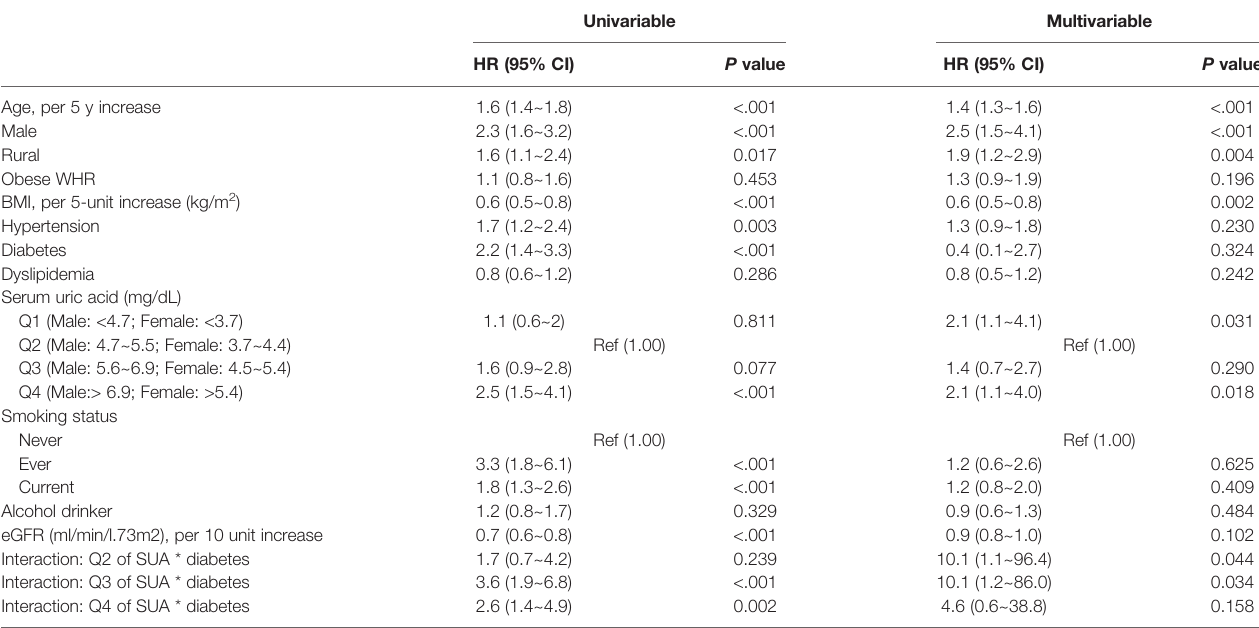
TABLE 2 | Hazard ratios of risk factors for all-cause mortality among all